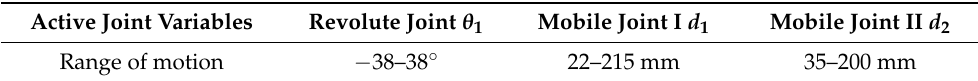
Table 2. Range of the active joints.